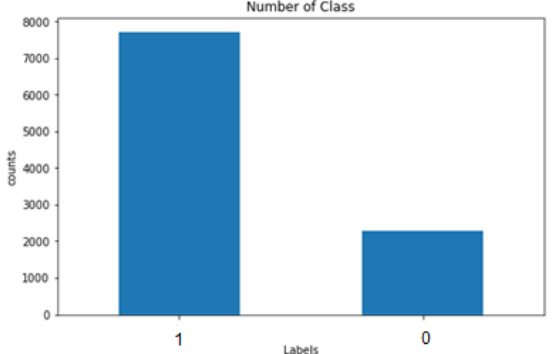
Figure 3. Graphical representation of the creation of the target variable.